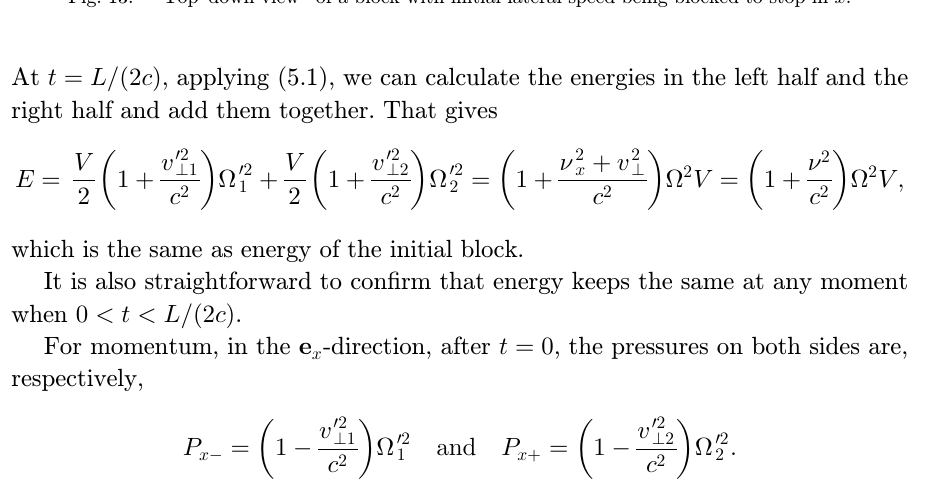
Fig. 13. \Top – down view" of a block with initial lateral speed being blocked to stop in x